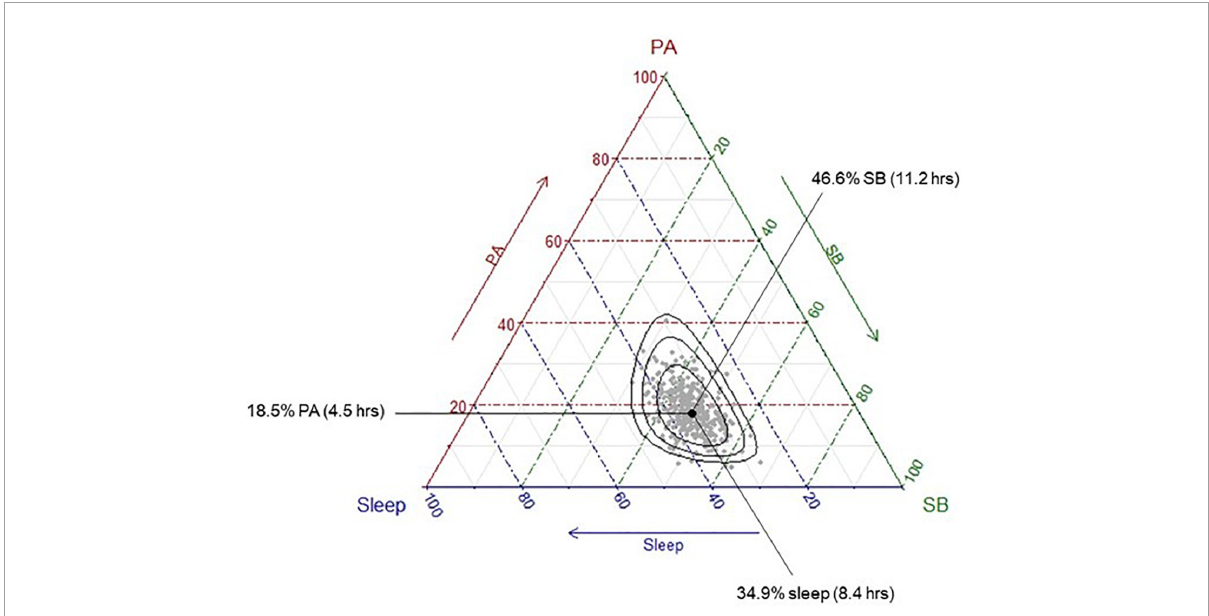
FIGURE1 Distribution of the sample time-use compositions. Each grey dot represents a single participant’s time-use composition. The black dot represents the average time-use composition of the sample, calculated as the geometric means of each activity, collectively adjusted to sum to 1,440 min. This differs to the arithmetic means, which are presented in Table 2 ; instead of summing the values and dividing by the number of values “ n, ” the geometric mean multiplies all the values and then takes the n th root. To convert the geometric mean to the compositional mean, the “closure” operator (a function part of Compositions package in R) is applied to the geometric mean, so that the centrality measure reflects the 1,440 min (24 h) in the day. The black dot represents this average composition (“compositional mean”) and shows that the average participant spends approximately 18.5% of their day in physical activity, 46.6% of their day in sedentary behaviour, and 35% of their day in sleep. Black ellipses represent 75, 95, and 99% confidence intervals,